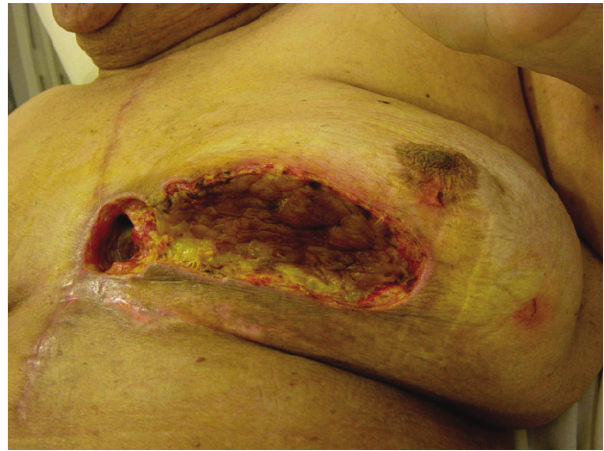
Figure 1 - Left inferior breast necrosis, confirmed by peripheral core needle biopsy, on the ninth postoperative day.